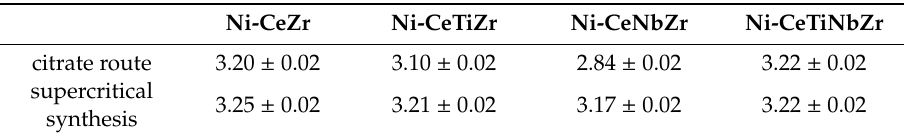
Table 4. Values of fundamental gap (E g ), eV.